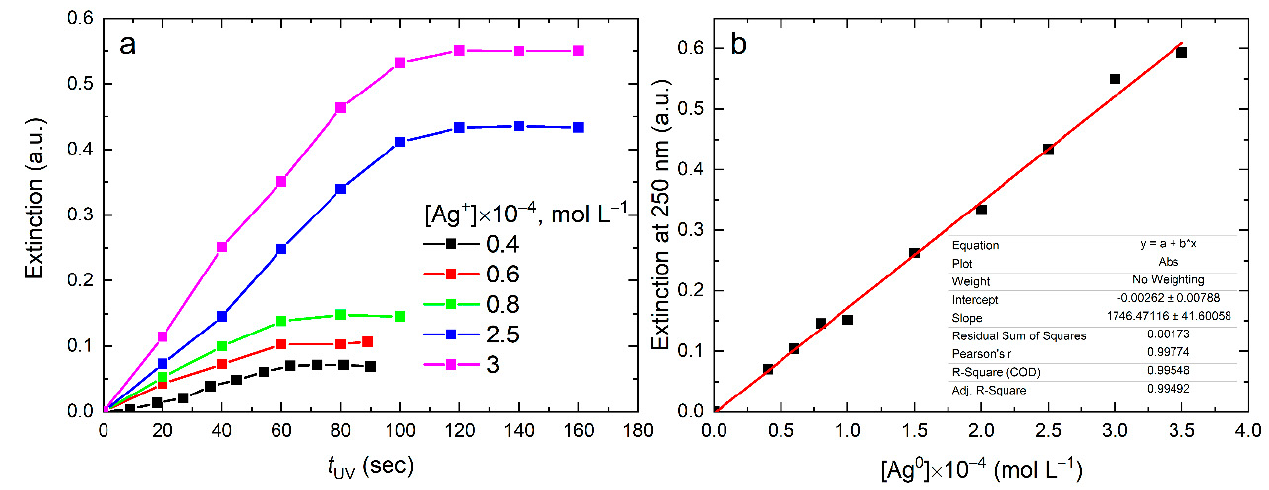
Figure 4. Variation of the absorption of the silver hydrosol during its formation under UV irradiation: variation of the IBT absorption with irradiation time ( a ) and absorption at 250 nm as a function of Ag 0 concentration ( b ). Solution: Ag + (0.4–3.0) × 10 − 4 mol L − 1 and C 2 O 42– 5 × 10 − 4 mol L − 1 . Optical path length: 5